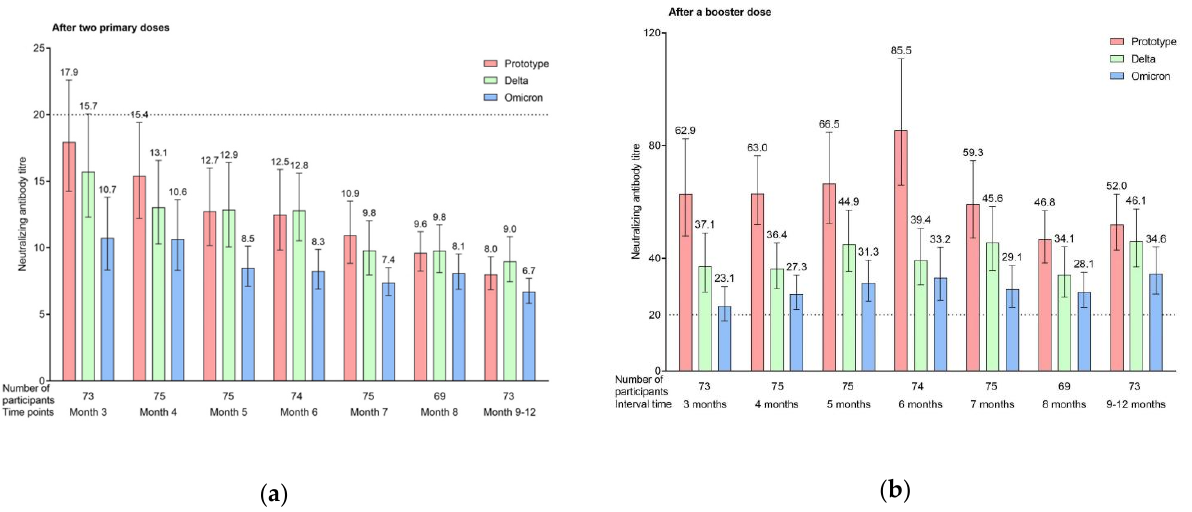
Figure 1. Neutralizing antibody titer against SARS-CoV-2 wild-type strain, and Delta and Omicron variants after primary and booster immunizations: ( a ) neutralizing antibody titer 3–12 months after two primary COVID-19 inactivated vaccine doses; ( b ) neutralizing antibody titer of a booster dose with different 3–12 month intervals.